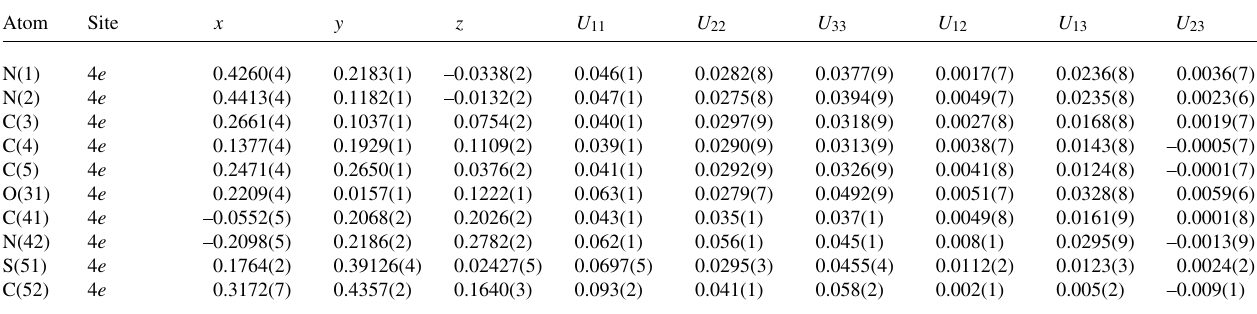
Table 3. Atomic coordinates and displacement parameters (in Å 2 )